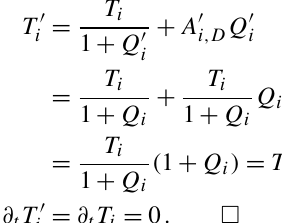
Table 2. Partition coefficients for the different modelled particles in 10 6 g of seawater per gram of particles. In parentheses is the value for the sensitivity simulation discussed in Sect.